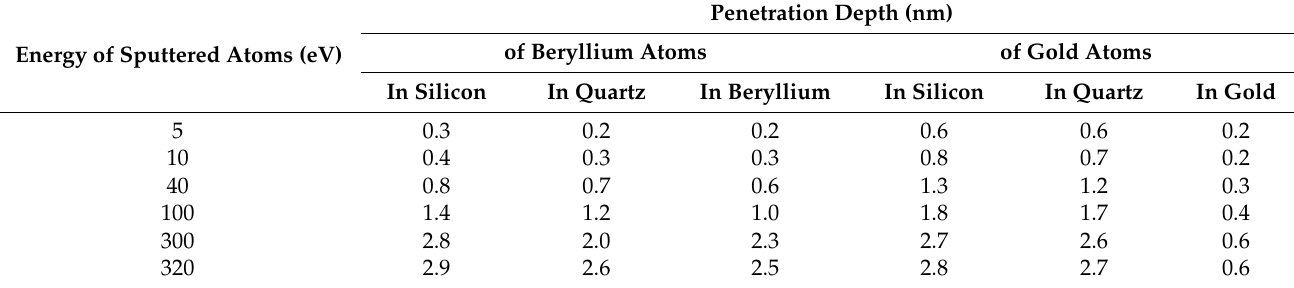
Figure 8. Energy distribution of the sputtered gold ( a ) and beryllium ( e ) atoms according to (7) on a logarithmic scale along the energy axis. Depth distribution of the sputtered gold atoms with energies of 10, 40, and 300 eV in silicon ( b ), quartz ( c ), and gold ( d ) and beryllium atoms with energies of 10, 40, and 300 eV in silicon ( f ), quartz ( g ), and beryllium ( h ). Table 3. Results of modeling the penetration depth of beryllium atoms in the silicon, quartz, and beryllium matrices and gold atoms in the silicon, quartz, and gold matrices with energies from zero to E max = 320 eV, using the SRIM